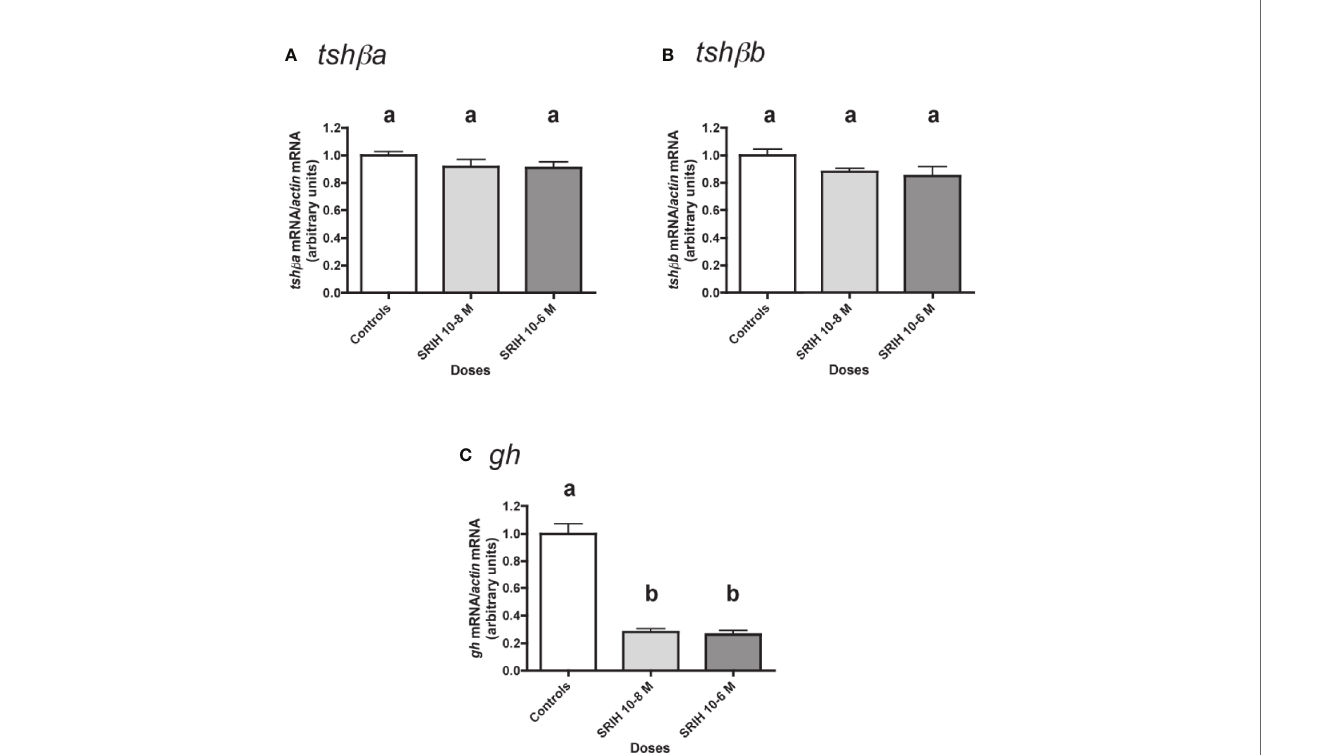
FIGURE 6 | Effects of SRIH on tsh b a , tsh b b , and gh transcript levels in primary cultures of Atlantic salmon pituitary cells. Pituitary cells from juvenile Atlantic salmons were treated with 10 -8 and 10 -6 M of SRIH for 10 days. The mRNA levels of tsh b a (A) , tsh b b (B) , and gh (C) were quanti fi ed by qPCR. Data were normalized against b -actin . The Figure displays the results from a representative experiment of three independent cell culture experiments. Mean ± SEM; n = 5 well replicates. Different letters indicate signi fi cant differences,